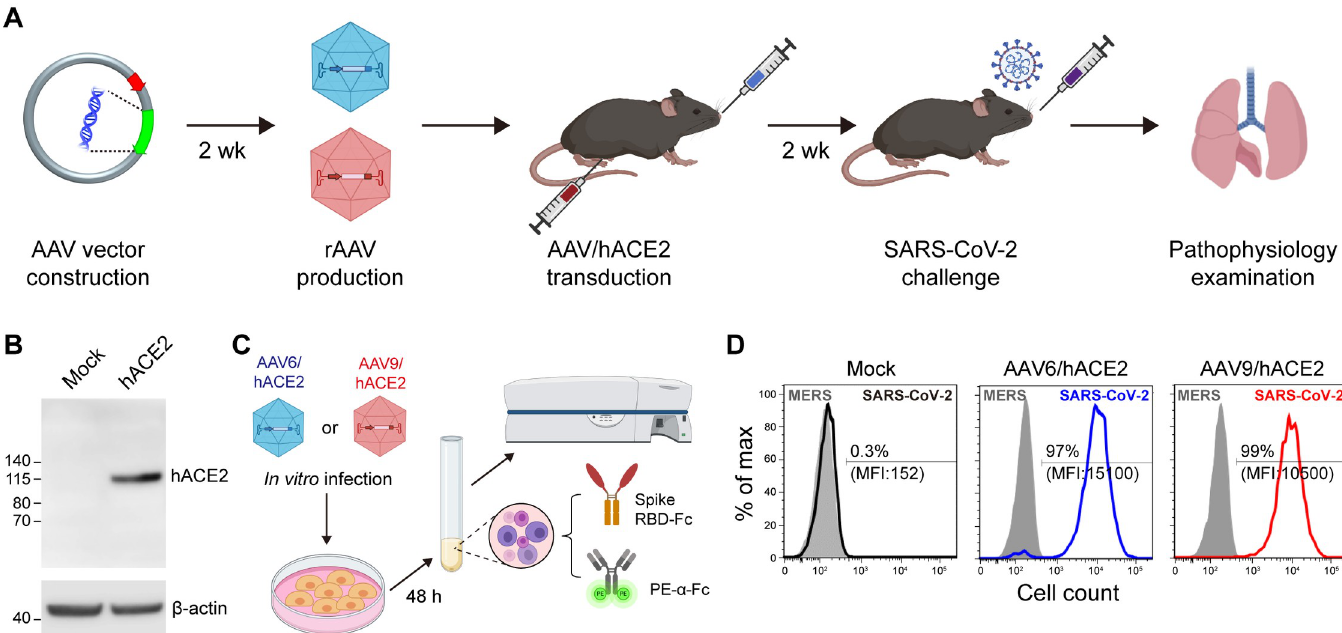
Fig 1. Establishment and examination of mouse model for COVID-19. (A) The workflow and time consumption of AAV vector construction and mouse model generation. (B) Western blot analysis of hACE2 expression in 3T3 cells mediated by the transfection of AAV expression vector carrying hACE2 gene. (C) The scheme depicts the procedure to examine the binding ability and specificity of hACE2 to SARS-CoV-2 RBD on AAV6/hACE2 or AAV9/hACE2 transduced 3T3 cells. (D) FACS analysis of hACE2 binding to SARS-CoV-2 RBD. MERS-CoV RBD serves as a negative control here. (MFI, mean fluorescent